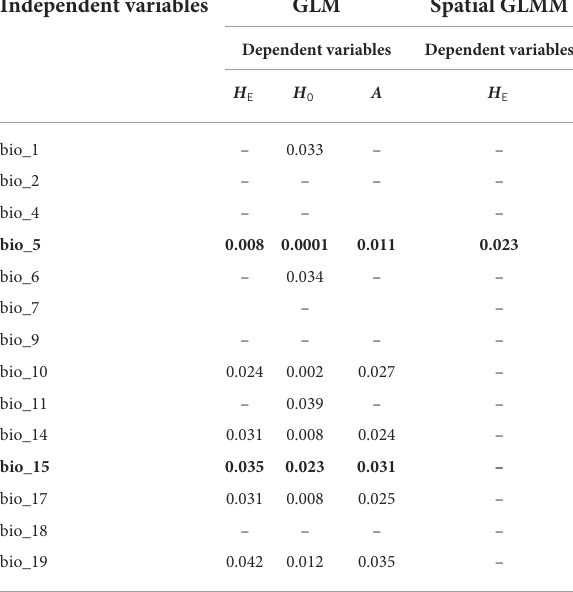
TABLE 6 Generalized linear model (GML) for the contribution of environmental variables to genetic diversity measures and spatially explicit generalized linear mixed models (spatial GLMMs) for the influence of environmental variables on genetic diversity measures based on 23 neutral SSR